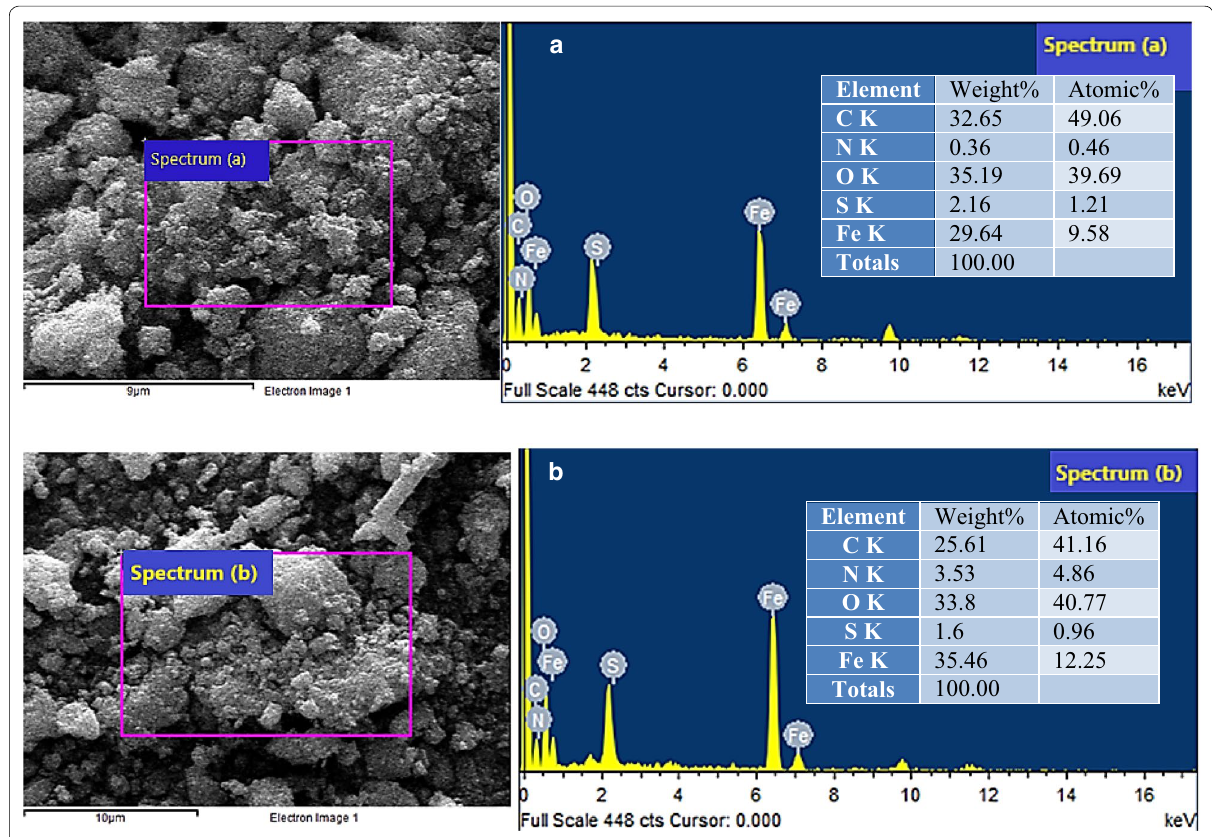
Fig. 6 SEM and EDX analysis of Fe 3 O 4 @CM a before reaction b after